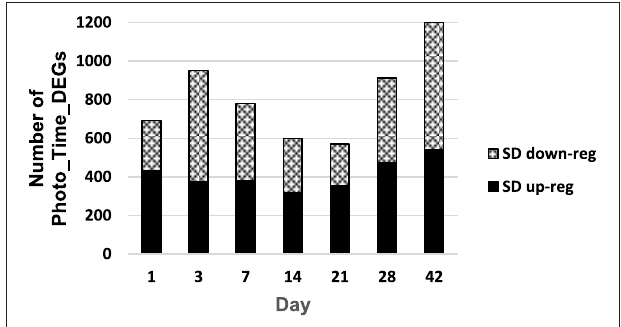
FIGURE 3 | Number of photoperiod x time differentially expressed genes (Photo_Time_DEGs) that (1) had a significant photoperiod x time interaction effect and (2) were differentially expressed between photoperiod treatments on a particular